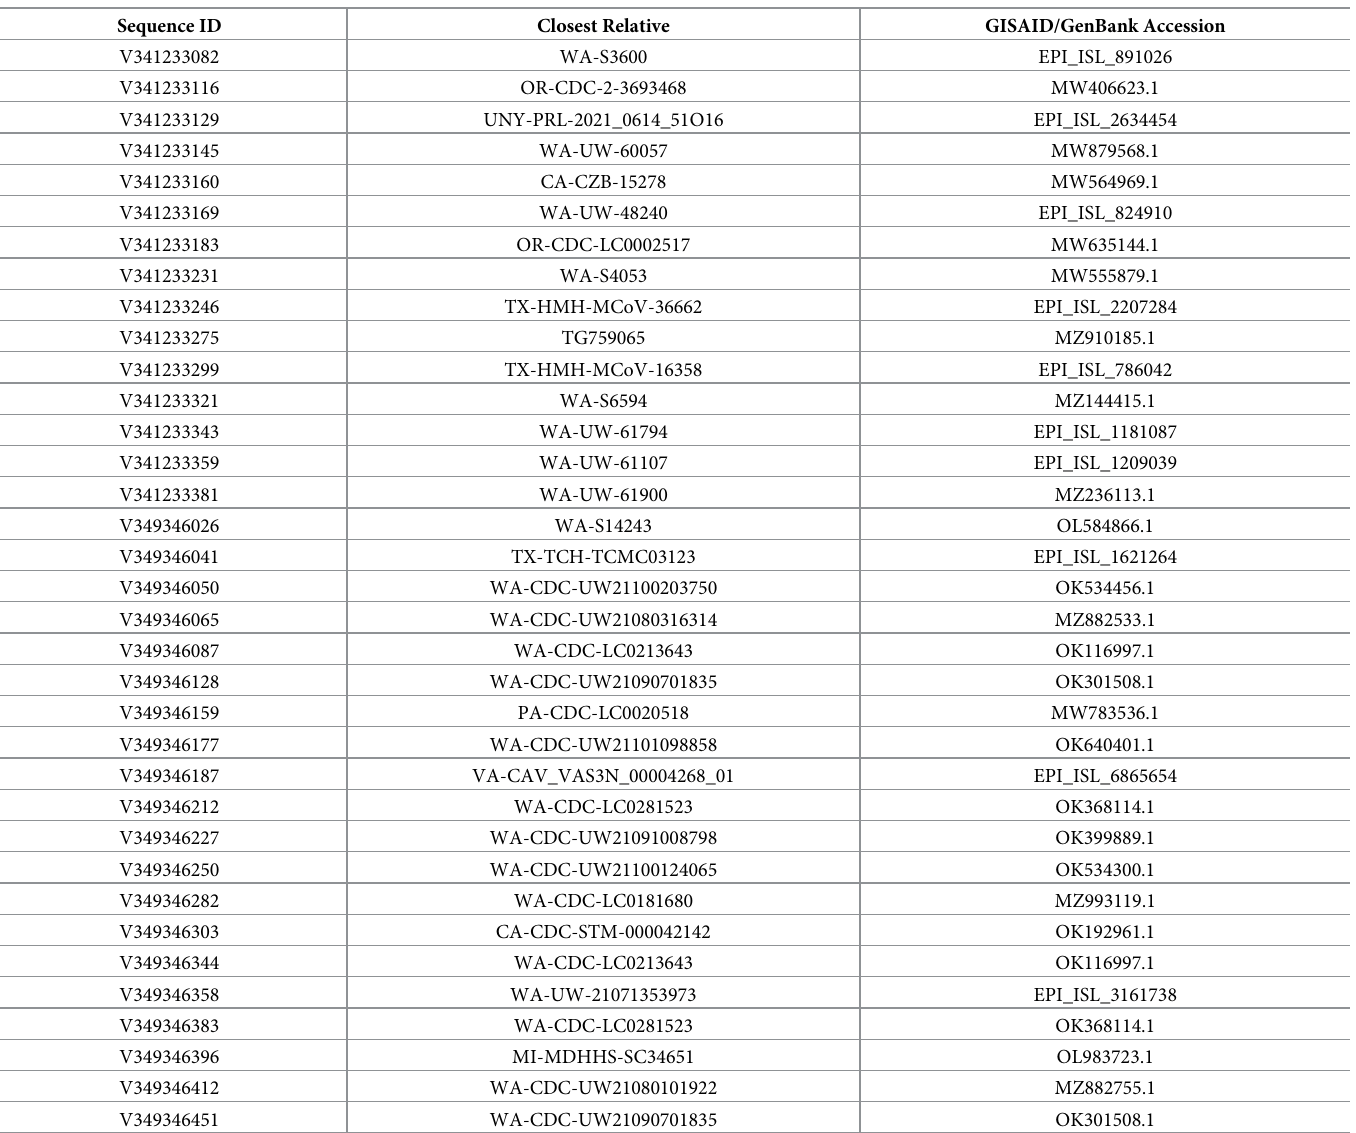
Table 2. Closest relatives to samples sequenced in this study. Sequence ID Closest